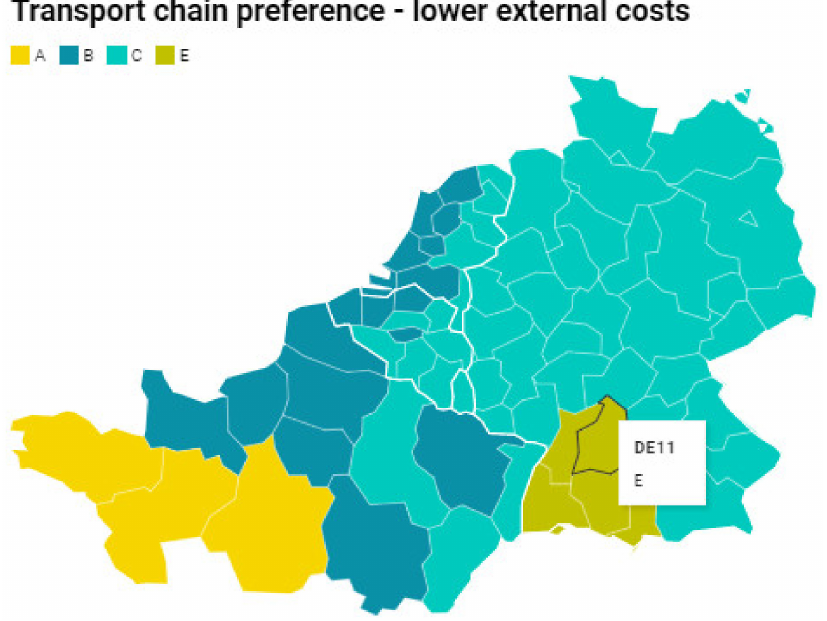
Figure 6. Transport chain preference when considering as a criterion the lowest external cost (created with